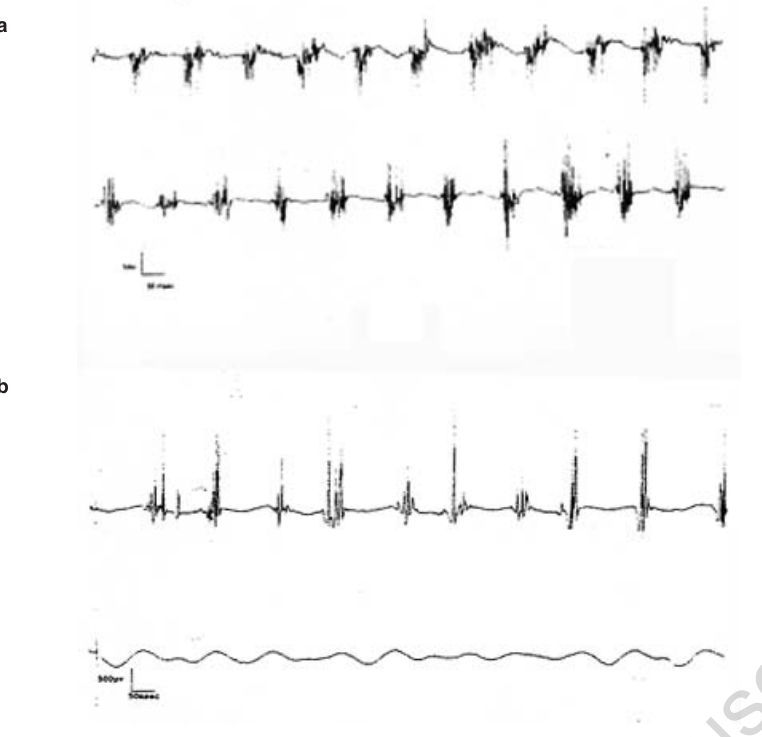
Figure 1. (a) EMG-right arm: motor unit grouping with a frequency of 10Hz in an alter- nating pattern between flexors and extensors (tremor). (b) EMG-right arm: spontaneous discharges firing at 8Hz with 2-4 units within a burst (myokymic discharges) in the right deltoid muscle (top recording). No findings in the left deltoid muscle (bottom recording).